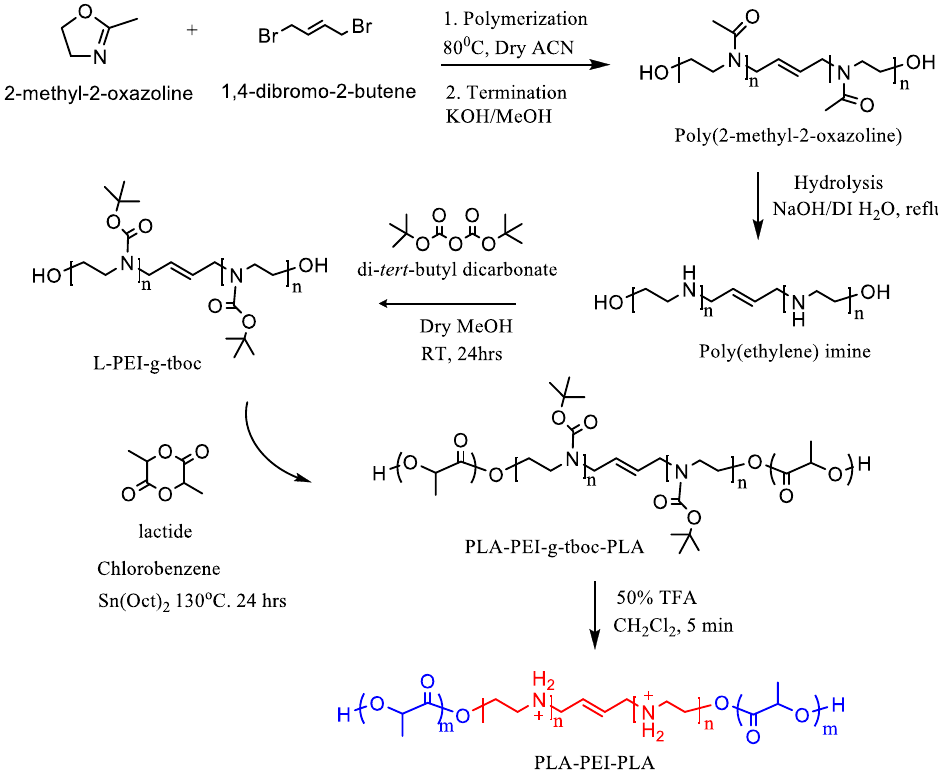
Figure 1. Schematic representation of 3LM and hydrogel